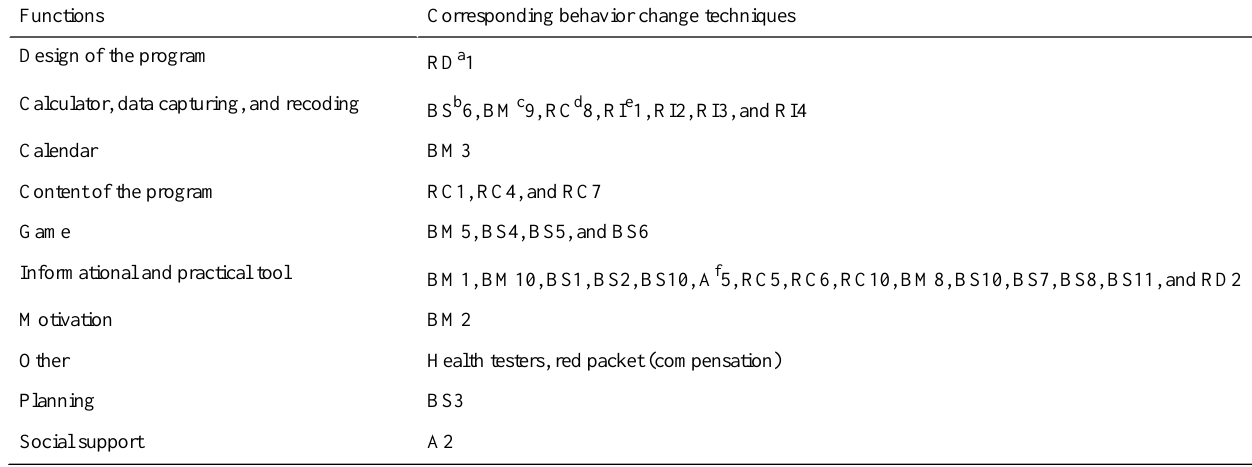
Table 1. Functions of the program and corresponding behavior change techniques